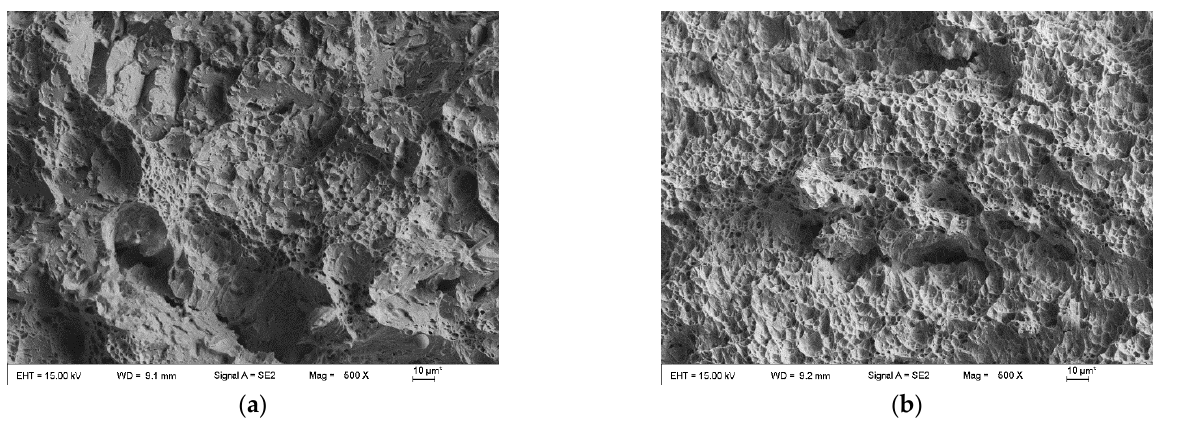
Figure 9. Impact fracture morphology of weld metal under different arc lengths. Arc length: ( a ) 2.9 mm; ( b ) 9.2 mm.